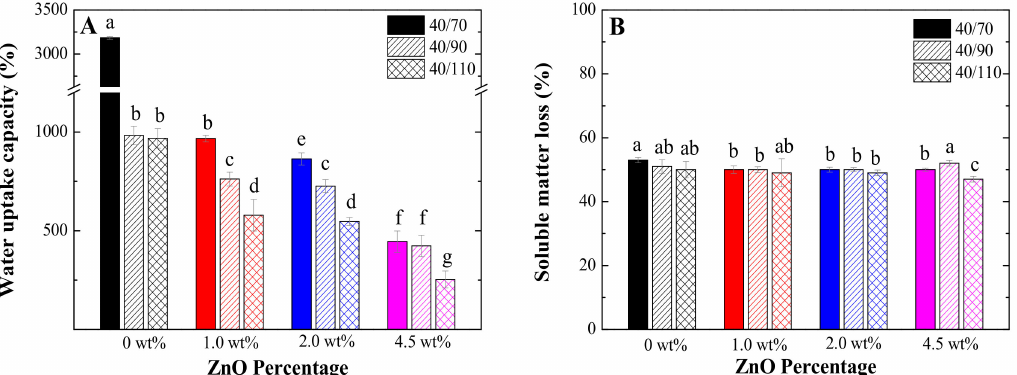
Figure 4. Water uptake capacity ( A ) and soluble matter loss ( B ) of the bioplastics with different ZnO nanoparticle concentra- tions (0 wt%, 1.0 wt%, 2.0 wt% and 4.5 wt%) processed at different mould temperatures (70 ◦ C, 90 ◦ C and 110 ◦ C). Different letters (a,b, . . . , g) in the bars mean that the values are significantly different ( p <